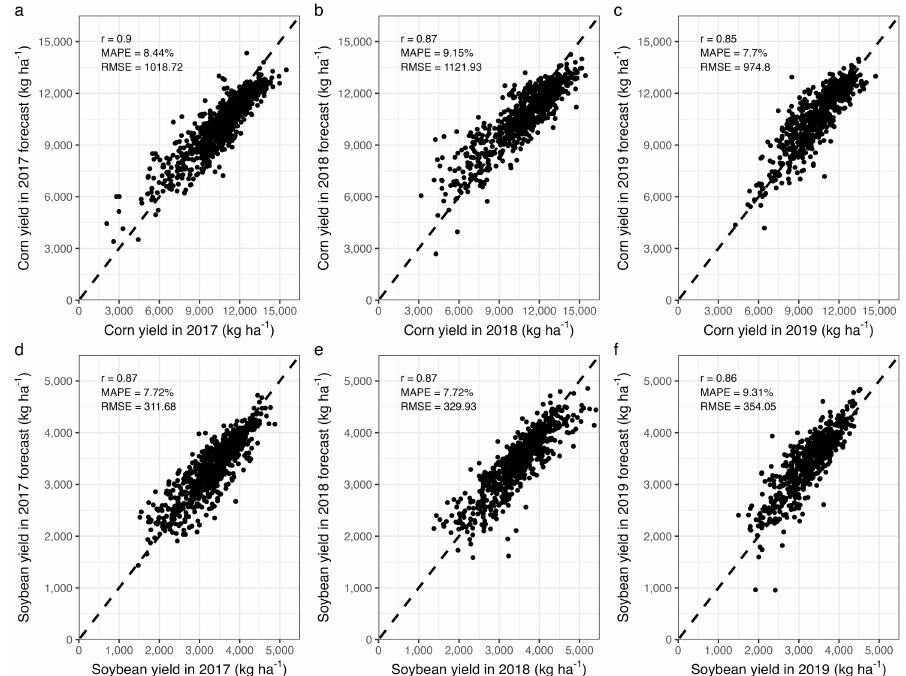
Figure 5. Comparisons between county-level yield reports and forecasts of ( a – c ) corn and ( d – f ) soybean yields in ( a , d ) 2017, ( b , e ) 2018 and ( c , f ) 2019. The crop yield forecasts were obtained using the LAI time series from the day of year of 89 to 209. The crop yield data were obtained from